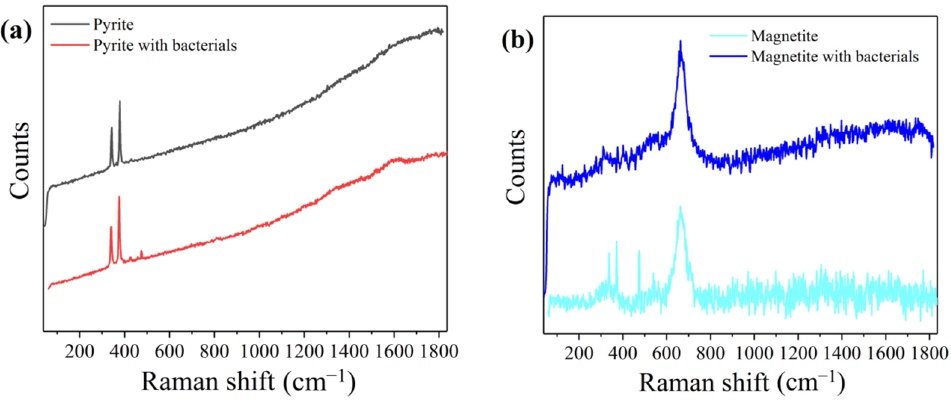
Figure 5. Raman spectra of pyrite and magnetite in different Cr (VI) reduction systems: ( a ) pyrite group, ( b ) magnetite group.